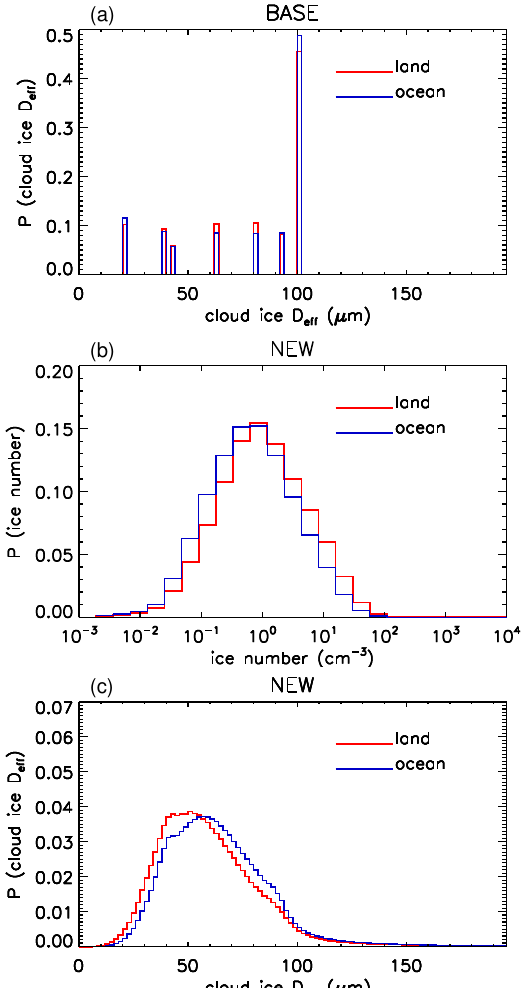
Fig. 6. (a) Global PDF of cloud ice effective diameter ( D eff ) from the BASE run. (b–c) In-cloud ice number concentration and cloud ice effective diameter ( D eff ) for the NEW run. Clouds with ice water content below 10 − 6 kgm − 3 are excluded from this